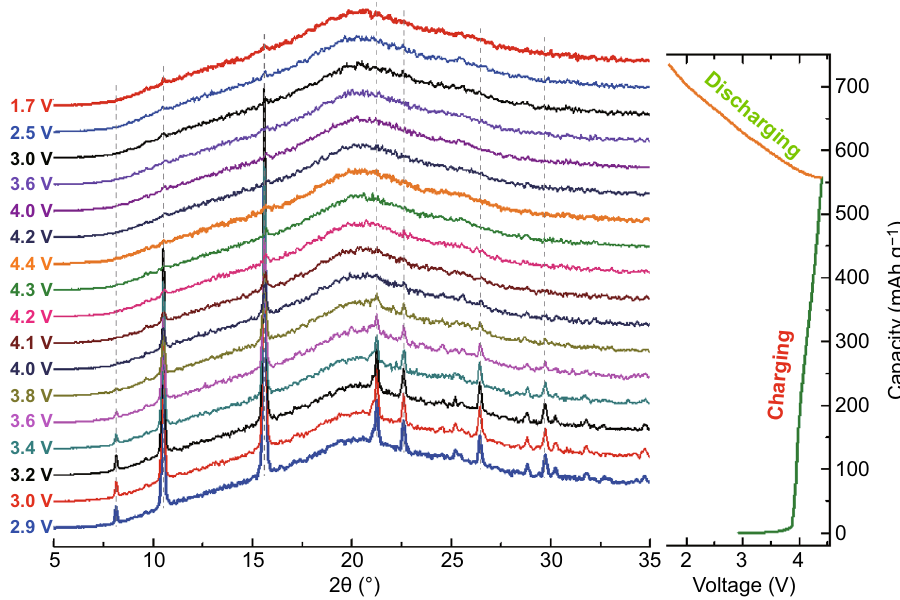
Fig. 7 In situ XRD patterns of the CuDEPP-50 electrode during the first cycle